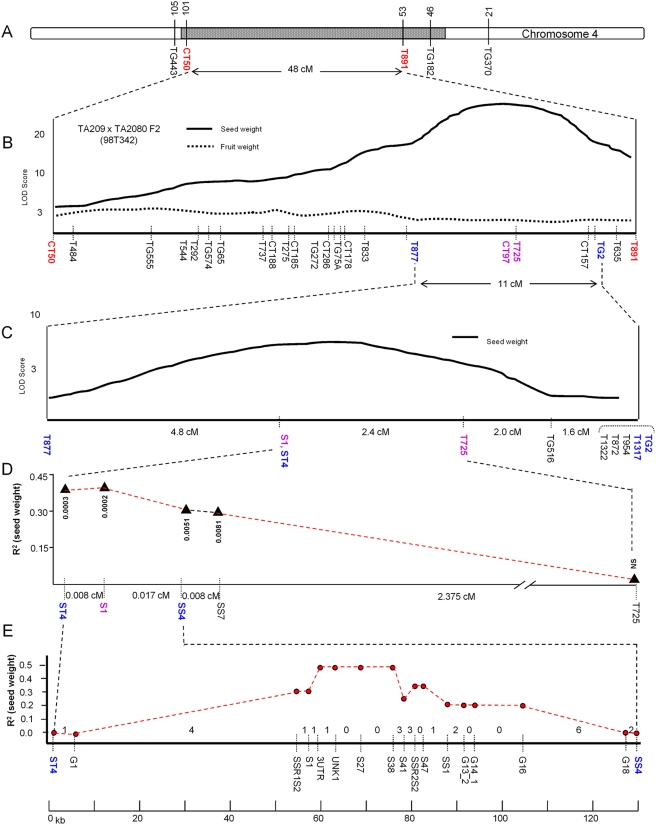
High resolution mapping of Sw4.1 QTL on tomato chromosome 4.(A) TA2080 S/S NIL showing the introgression region from S. pimpinellifolium containing Sw4.1 QTL (shaded). (B) Sw4.1 mapping of F2-population of 150 individuals (TA209 – L/L NIL×TA2080 – S/S NIL) within a 48 cM region. (C) Sw4.1 mapping within a 11 cM region from 140 individuals from a F2 heterozygous individual (98T342-95). (D) Sw4.1 mapping within a 2.4 cM region from recombinants selected from 1,000 seeds from F2 heterozygous individuals. The S1 marker was then used to isolate and sequence the 130 kb BAC clone LE_HBa0077O05. (E) Sw4.1 mapping within the ∼130 kb BAC LE_HBa0077O05 from recombinants selected from 9,000 seeds from F2 heterozygous individuals. The numbers between markers represent the number of crossover events in each interval.